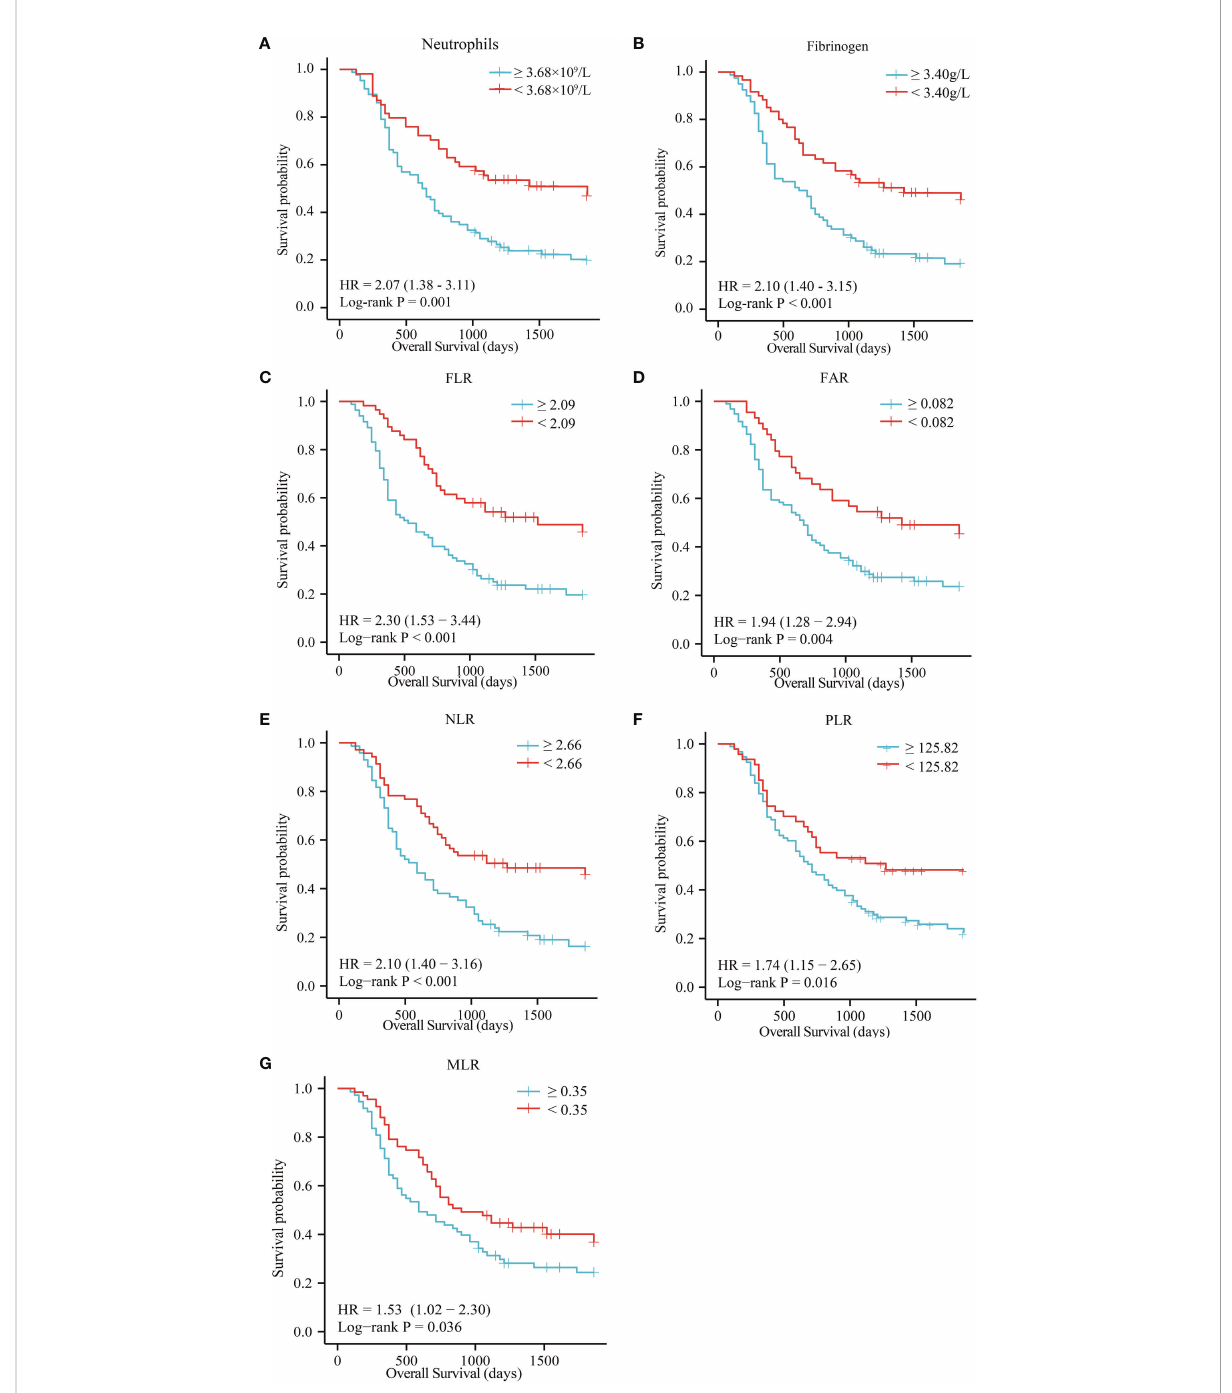
FIGURE 2 OS of patients with resectable ECC based on neutrophils (A) , fi brinogen (B) , FLR (C) , FAR (D) , NLR (E) , PLR (F) , and MLR (G) . OS, overall survival; FLR, fi brinogen-to-lymphocyte ratio; FAR, fi brinogen-to-albumin ratio; NLR, neutrophil-to-lymphocyte ratio; PLR, platelet-to-lymphocyte ratio; MLR monocyte-to-lymphocyte